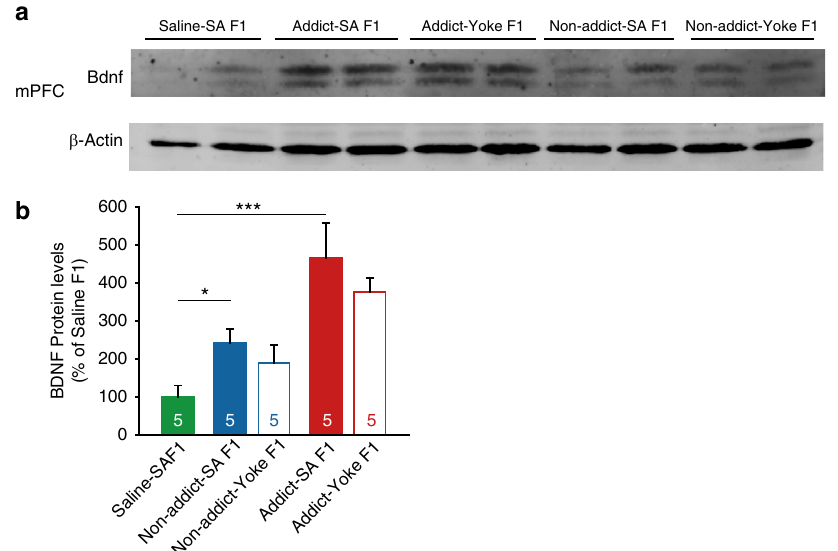
Figure 6 | Elevated BDNF level in F1 correlates with the amount of cocaine taken by F0 fathers. BDNF level in mPFC of cocaine naive F1 rats of Saline-SA, Non-addict-SA, Non-addict-Yoke, Addict-SA and Addict-Yoke groups. ( a ) Representative blotting of two samples from each group was shown. ( b ) Statistical analysis of BDNF level in each group. BDNF level normalized by b -actin was acquired, and then relative protein level of each sample was divided by average of BDNF/ b -actin in Saline F1 group. One-way ANOVA, F (4, 20) ¼ 7.251, P o 0.001; Bonferroni post hoc , *** P o 0.001, compared with Saline F1. n ¼ 5 each. Data are expressed as mean ± s.e.m.